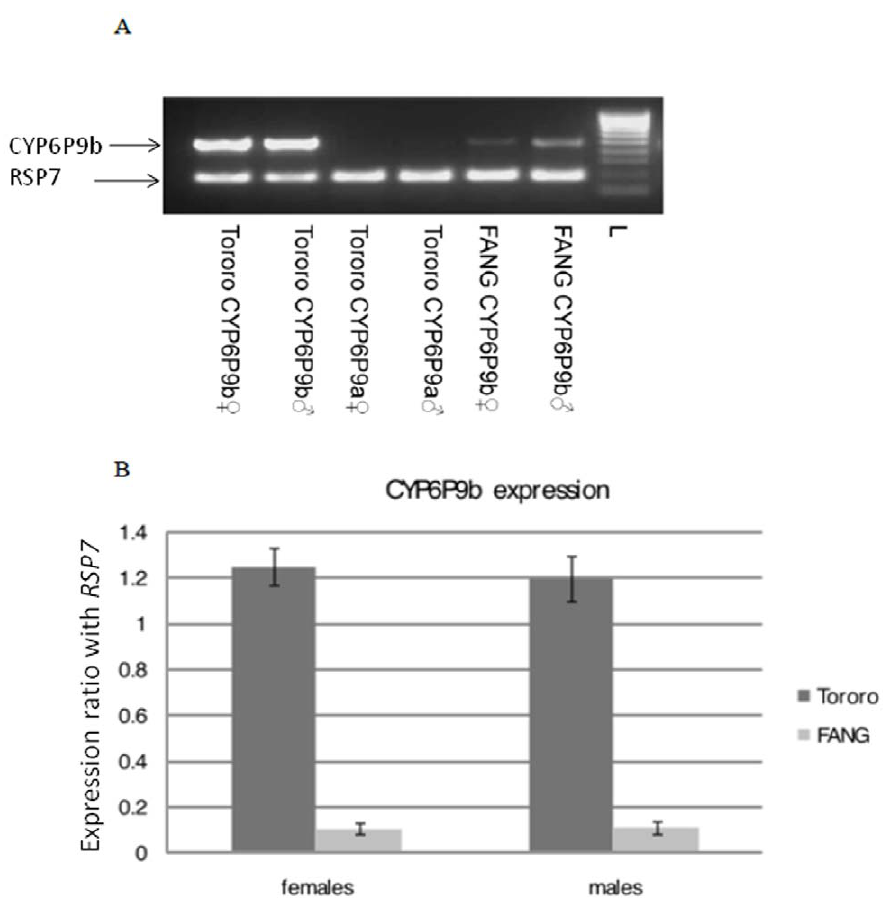
Figure 2. Transcription profile of candidate genes in the Tororo population. A) RT-PCR gel of both copies of CYP6P9 . B) Comparison of the patterns of gene expression of CYP6P9b between the resistant field sample of Tororo and the laboratory susceptible strain FANG. The normalised expression ratio of CYP6P9b against RSP7 gene is represented on the vertical axis.